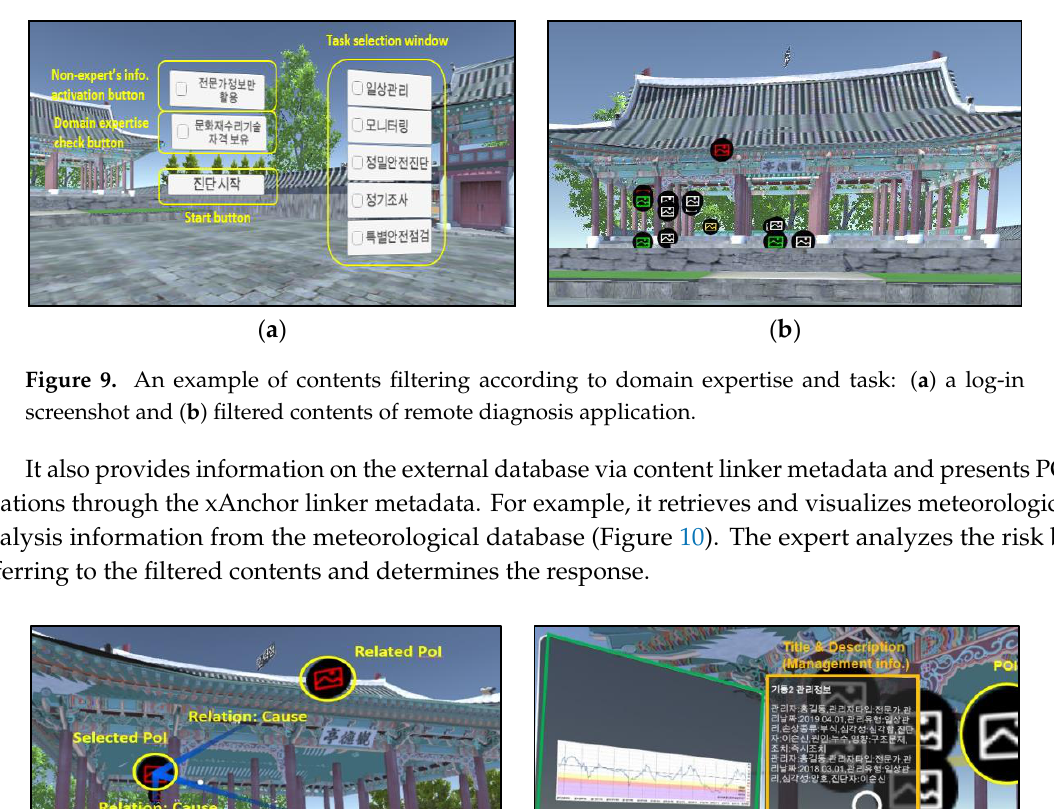
Figure 8. A photogrammetry 3-D model of column2.